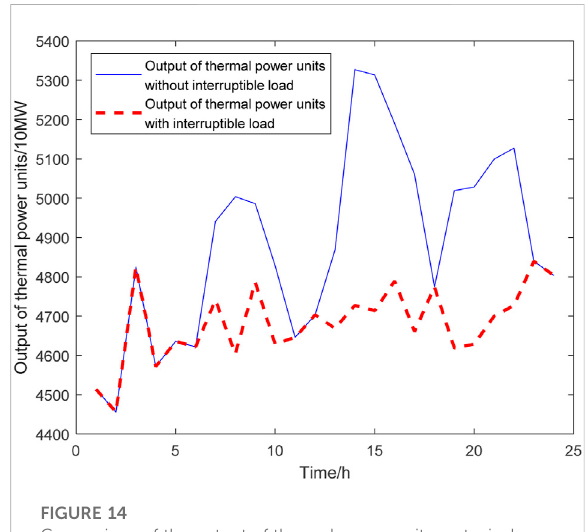
FIGURE 12 Comparison of the output of thermal power units on typical day 2 with 2 million kW interruptible loads.